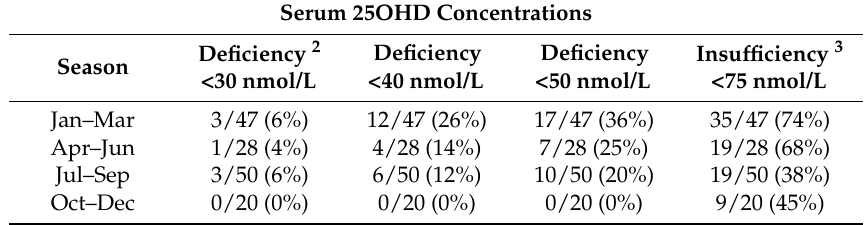
Table 4. Prevalence of vitamin D deficiency and insufficiency among Canadian children and adolescents (2–19 y) with sickle cell disease based on mean serum 25OHD concentrations by season 1 .